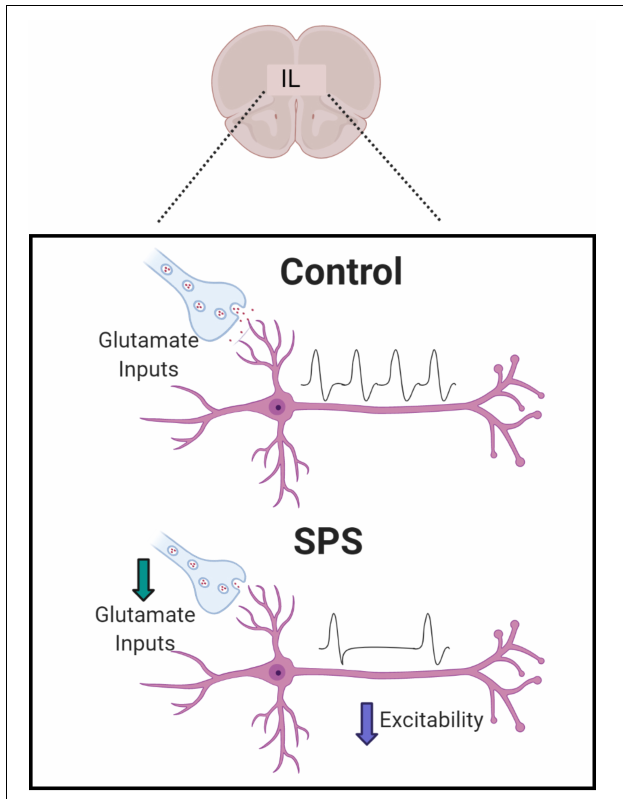
FIGURE 4 | Summary of observed effects. SPS causes a decrease in excitatory synaptic drive and intrinsic excitability of pyramidal neurons which are the major output neurons in Layer V of IL. SPS has been shown to reduce glutamatergic excitatory synaptic drive driven mainly by reduction in presynaptic glutamate inputs. SPS was found to delay the decay of GABA currents but that did not have an effect on overall inhibitory synaptic